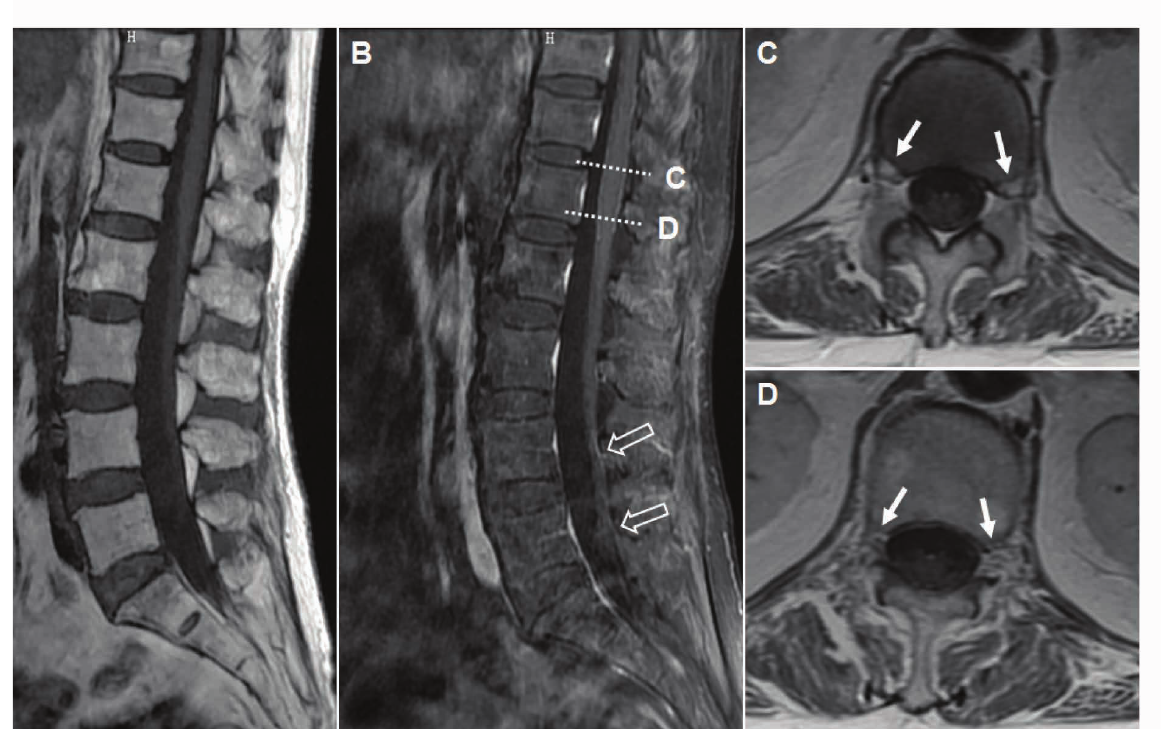
Figure 1: Lumbar magnetic resonance imaging (MRI) results of a 64-year-old woman with Guillain-Barré syndrome. Pre-contrast sagittal SE T1-weighted MRI demonstrated no abnormality of the cauda equina, conus medullaris, and dural sac (A). Contrast-enhanced fat suppressed sagittal T1-weighted MRI (B) and contrast-enhanced axial T1-weighted MRI (C-D) showed moderate enhancement of the nerve roots (solid arrows) and cauda equina (open arrows). The levels of figures C-D were shown as the dotted lines in figure